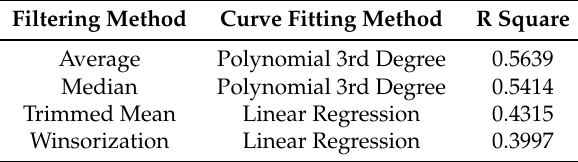
Table 5. RSSI to distance outdoor band 2.